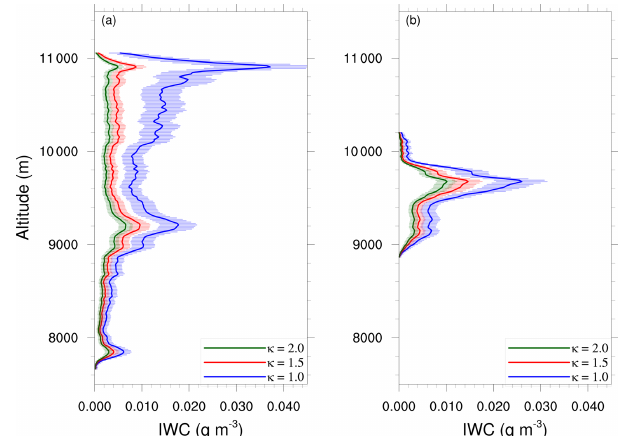
Figure 6. Dependence of the retrieved IWC on the backscatter-to- extinction ratio for (a) the lidar profile measured on 30 Novem- ber 2016 at 16:20UTC and (b) the lidar profile measured on 30 November 2016 at 18:11UTC. Shaded zones represent the re- trieval errors.